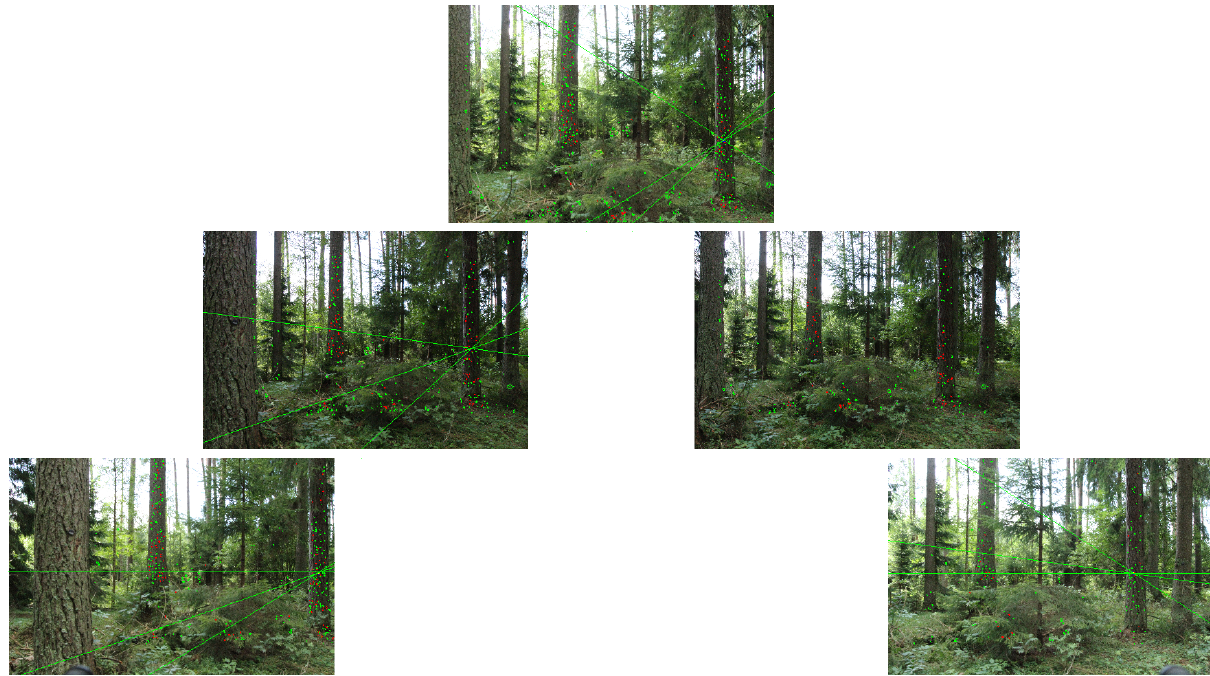
Figure 4: A set of images from the five-camera rig. The relative positioning of the images indicate the relative position of the camera within the rig. The green lines are the epipolar lines for one point.